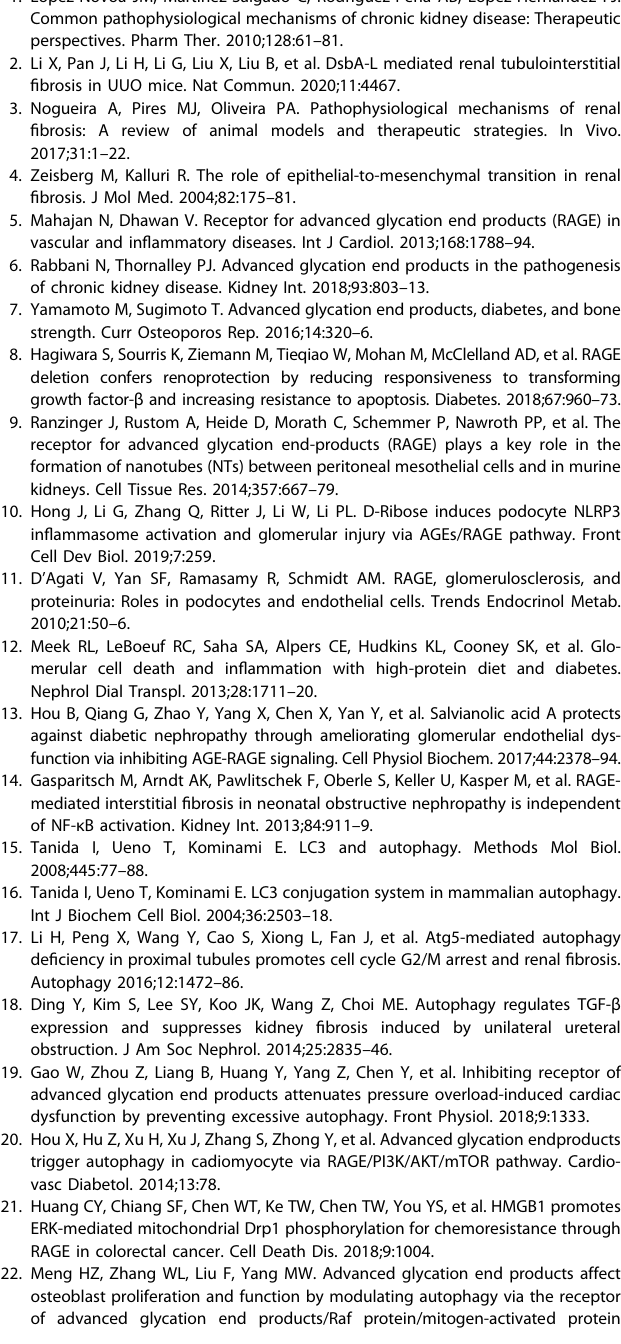
Fig. 8 The UUO-induced renal fi brosis was ameliorated via the downregulation of Stat3 and autophagy in PT-RAGE-KO mice. The left ureter of PT-RAGE-KO and PT-RAGE-WT littermate mice was ligated for 7 days to establish a UUO model. A Hematoxylin and eosin staining and the representative Masson ’ s trichrome staining. B Quanti fi cation of tubulointerstitial fi brosis in the kidney cortex. C Immunohistochemistry of FN & Collagen I & Collagen III and α -SMA staining. D Quanti fi cation of the FN & Collagen I & Collagen III and α -SMA -positive cells in the kidney cortex. E , G Immunoblot analysis of fi bronectin & Col I&III, α -SMA and p-Stat3 & Stat3, Atg7, LC3, p62. F , H Analysis of the grayscale image between them. Original magni fi cation ×400. Scale bar:100 µM. Data are expressed as means ± s.d. ( n = 6). # P < 0.05 versus PT-RAGE-WT with the sham group. * P < 0.05 versus PT-RAGE-WT with the UUO group. Each experiment A , C was repeated six times independently with similar results. B , D indicate the statistical Student ’ s t test used (means ± s.d., n = 6, P < 0.05). Data are expressed as means ± s.d. ( n = 6). # P < 0.05 versus sham group. * P < 0.05 versus PT-RAGE-WT with the UUO group.